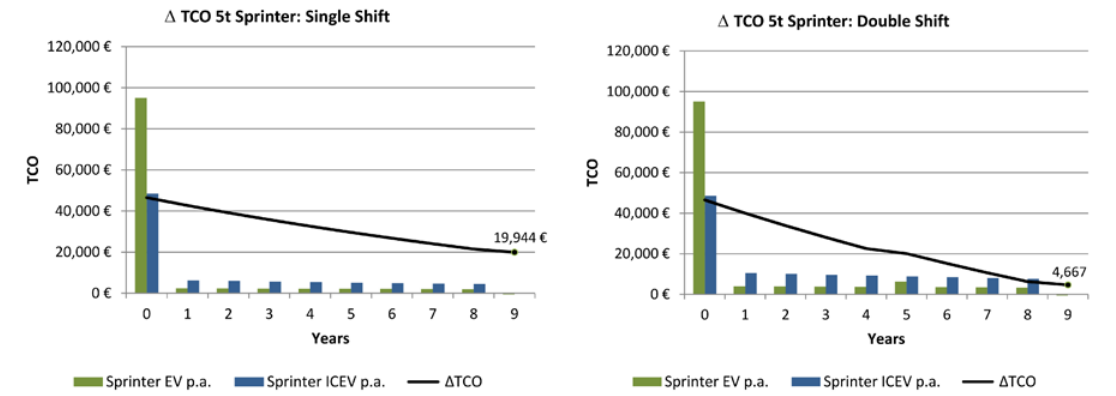
Figure 2. TCO difference of the conventional 5 ton Mercedes Sprinter and Plantos